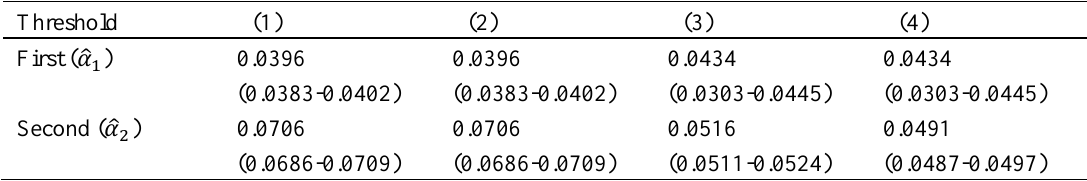
Table 2 : Threshold estimates [95% confidence